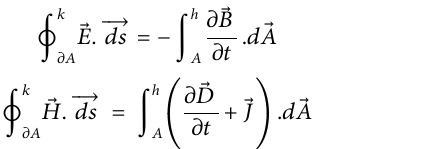
Frontiers in Built Environment |